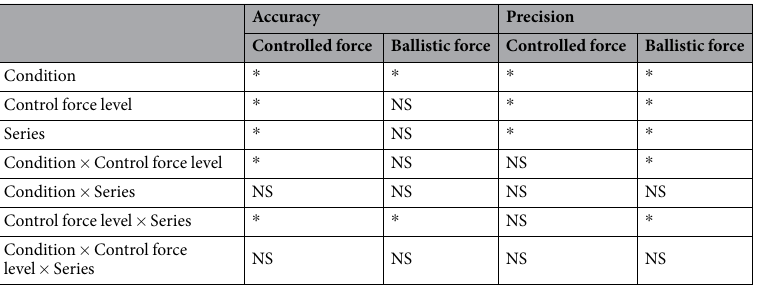
Table 3. Summary of results of three-way repeated measures analysis of variance (ANOVA) for accuracy and precision of task performance. * P < 0.05; NS: not significant